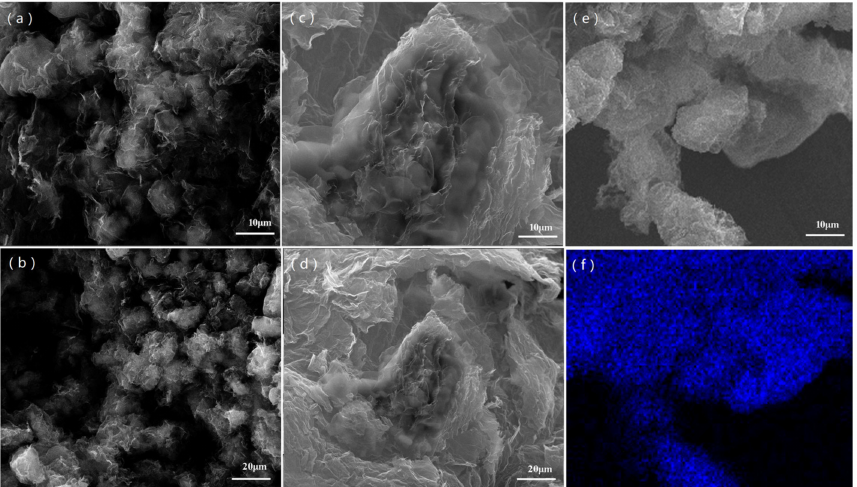
Figure 1. SEM images of rGO-S-HT ( a , b ), rGO-S-T ( c , d ), and SEM image with corresponding elemental mapping of rGO-S-HT for S ( e , f ).